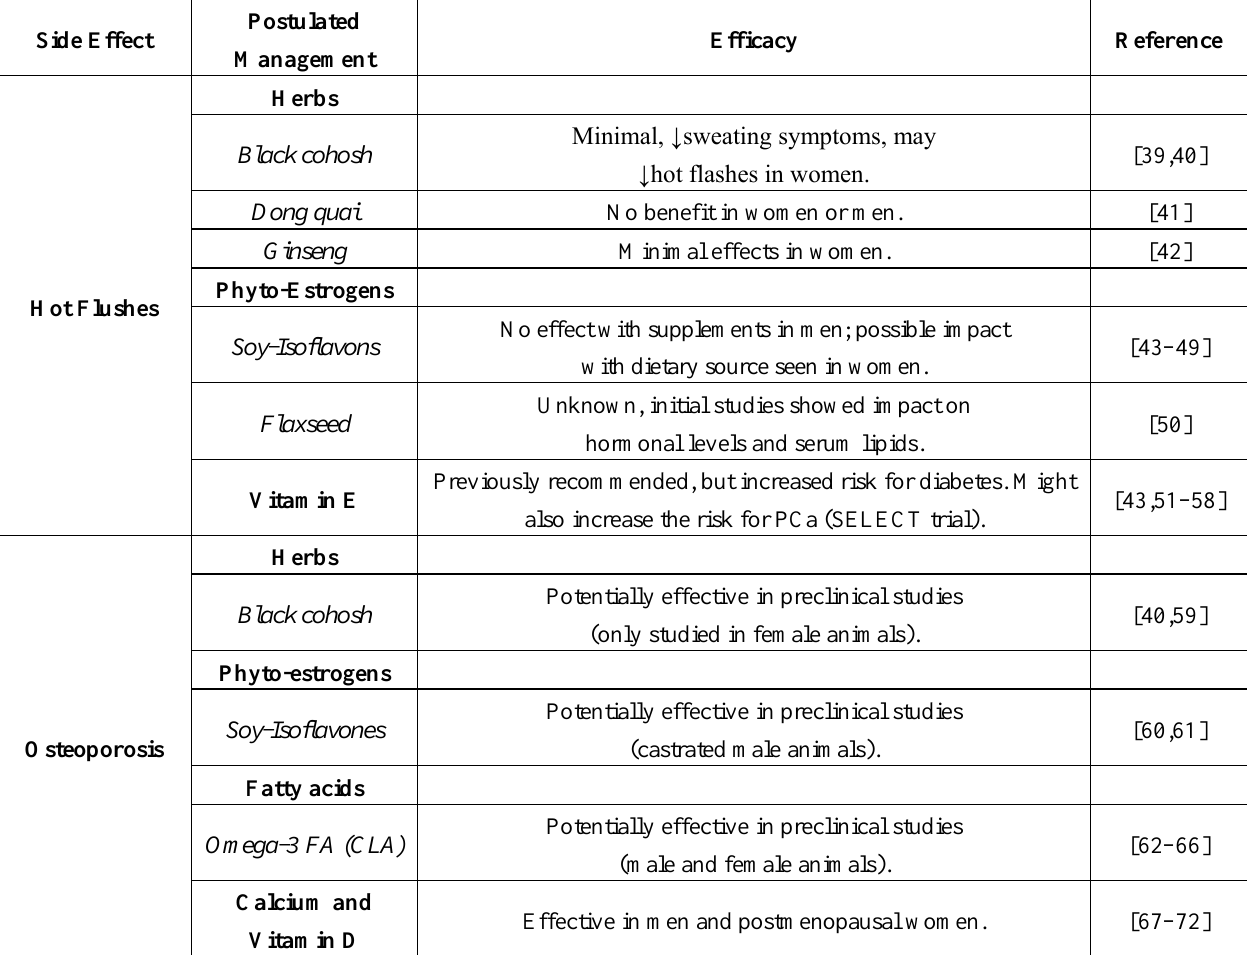
Table 2. Summary of dietary supplements for the management of androgen deprivation therapy (ADT) side